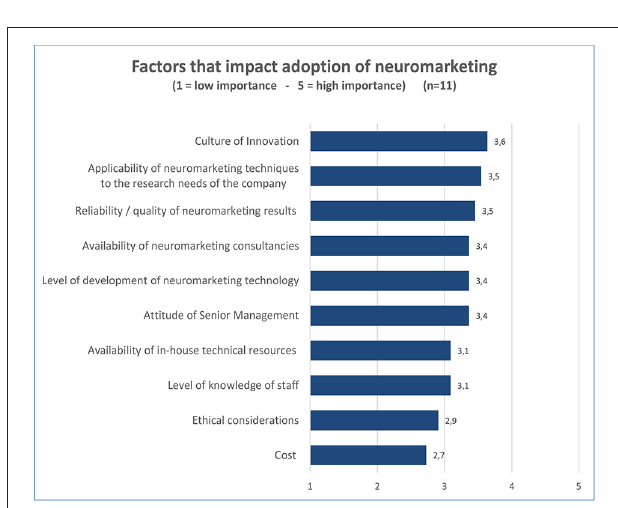
FIGURE 7 | Factors that impact adoption of neuromarketing.